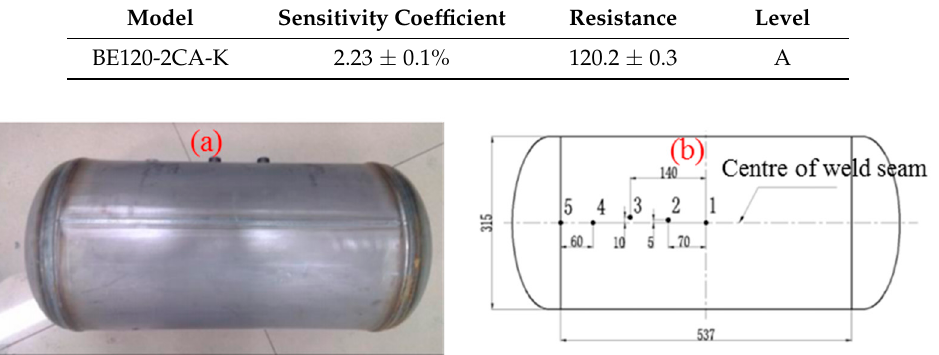
Figure 4. Connection modes of strain gauge lead in longitudinal and transverse directions ( a ) and removal of strain gauge lead ( b ). 2.5. Diffusible Hydrogen Content Test The methods for determination of diffusible hydrogen in welding seam are gas chromatography, mercury method, and glycerin method. Gas chromatography is fast and accurate, but it is not suitable for testing in the field of welding because of the equipment. The mercury method is more accurate